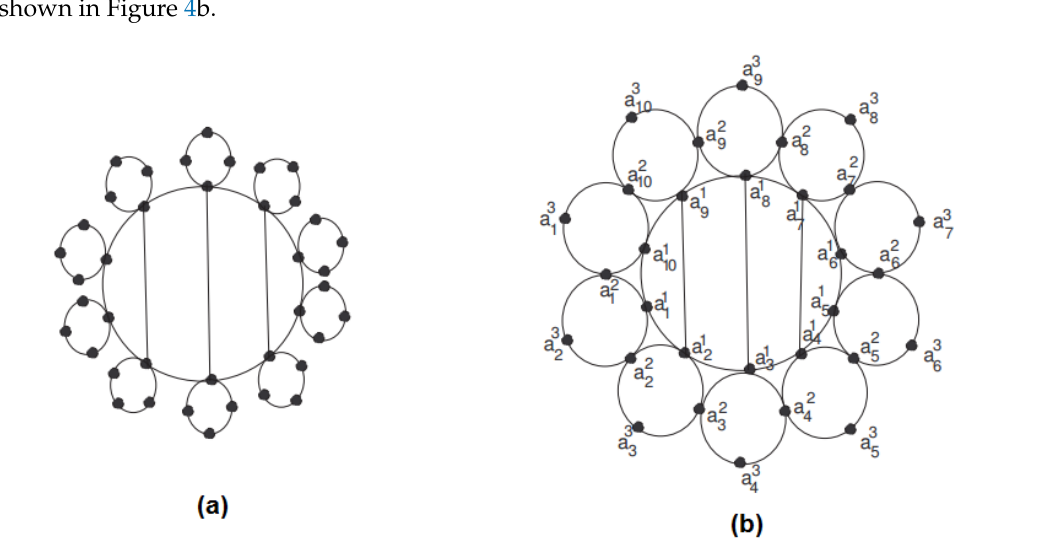
Figure 4. ( a ) The graph of ( P 2 × P 5 )( C 4 ) ; ( b ) The graph of ( P 2 × P 5 )( C 4 ) c